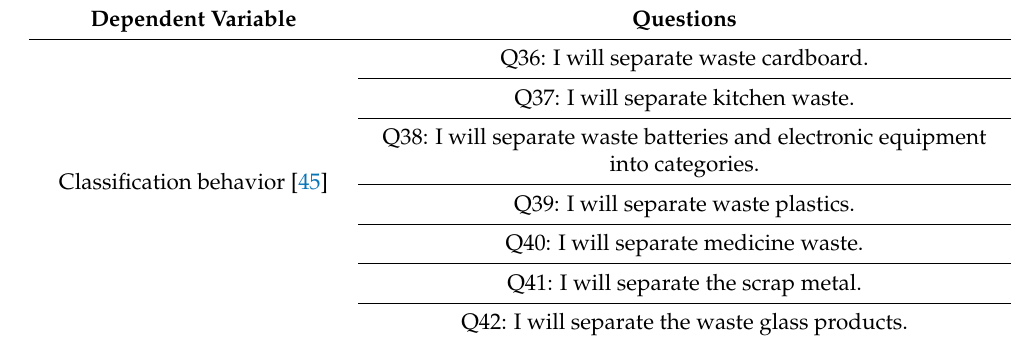
Table 9. Classification behavior questions.